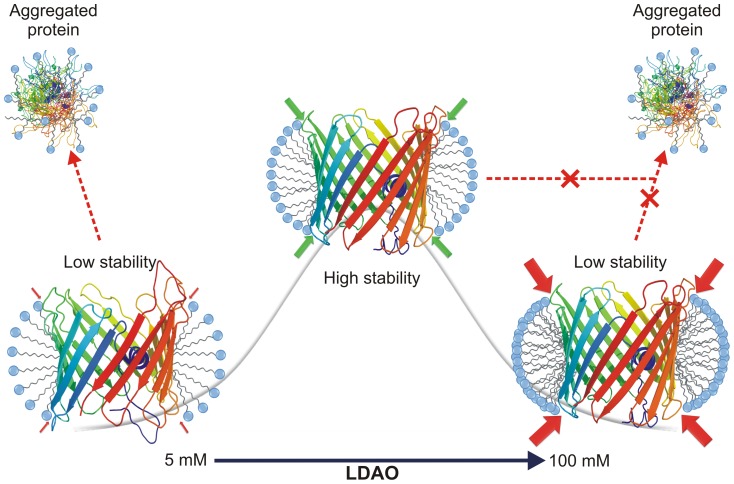
Schematic illustrating the relationship between hVDAC-2 stability and LDAO concentration.Highest barrel stability (represented by the gray line in the background) to thermal denaturation, is achieved only when hVDAC-2 is refolded from GdnHCl into an optimal LDAO concentration (65 mM) and LPR (2600∶1). Subsequent to folding, maintaining stability of the refolded WT and C0 barrels depends on the extent of lateral pressure (red or green filled arrows) exerted by the LDAO micelles on the protein scaffold. Optimal lateral pressure is achieved in LDAO concentrations of ∼13–65 mM (LPR 2600∶1–13000∶1; green arrows). Above and below this concentration, stability of hVDAC-2 is lowered due to the sub-optimal packing of LDAO against the barrel (indicated by red arrows). At low LDAO concentrations, the protein displays a tendency to aggregate (shown by dotted red arrow), while at higher concentrations aggregation is negligible. However, in high LDAO concentrations, very high lateral pressure of the micelles closely packed against the protein [46], may play a major role in barrel destabilization and the corresponding loss observed in the unfolding cooperativity.